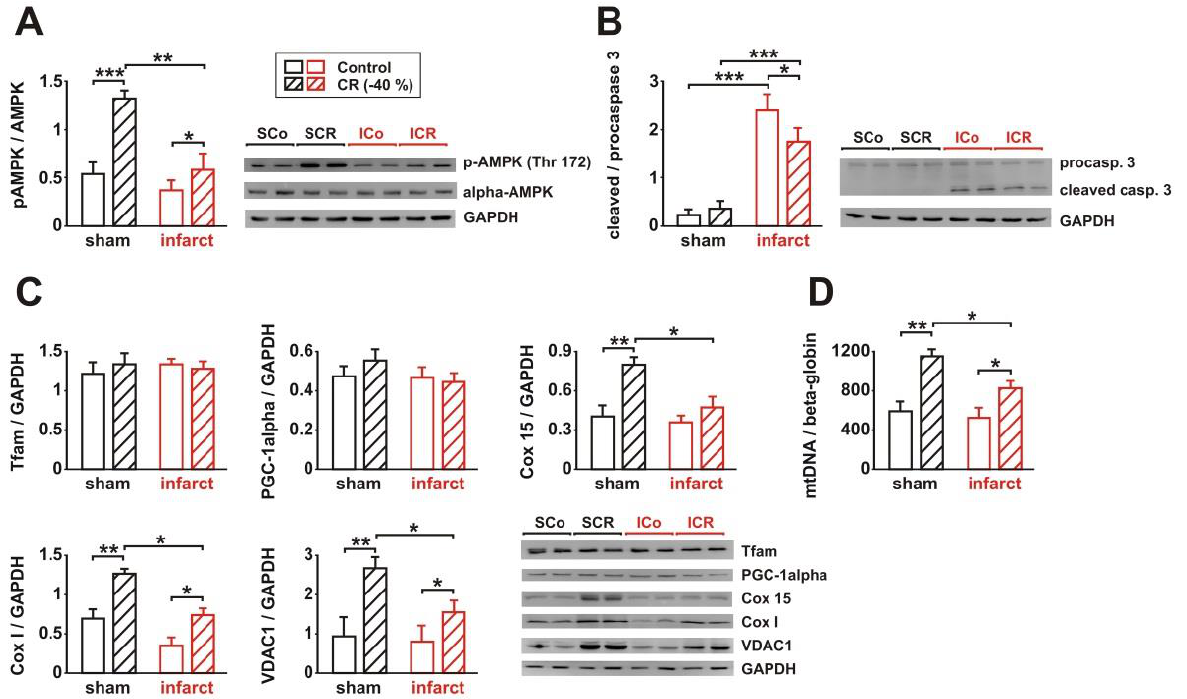
Figure 3. Effect of 8 weeks CR on AMPK activation, apoptosis, and mitochondrial biogenesis. ( A ): Representative Western blots and quantification of phosphorylation of AMPK (at Thr172), normalized to alpha AMPK, in the LV of sham or infarct rats, following 8 weeks of control or CR diets. ( B ): Representative Western blots and quantification of full-length and large fragment (17/19 kDa) of cleaved, activated caspase-3 in the LV of sham or infarct rats, following 8 weeks of control or CR diets. GAPDH served as loading control. ( C ): Representative Western blots and quantification of protein expression of Tfam, PGC-1alpha, mitochondrial components of complex IV (Cox 15 and I) and VDAC1, normalized to GAPDH, in LV tissue. ( D ): Relative copy number of mtDNA per diploid nuclear genome, as measured by real-time PCR. All data are mean ± SEM. n = 5–6 animals per group, *: p < 0.05; **: p < 0.01; ***: p < 0.001. Full size blots are provided in Supplementary Figure S2.